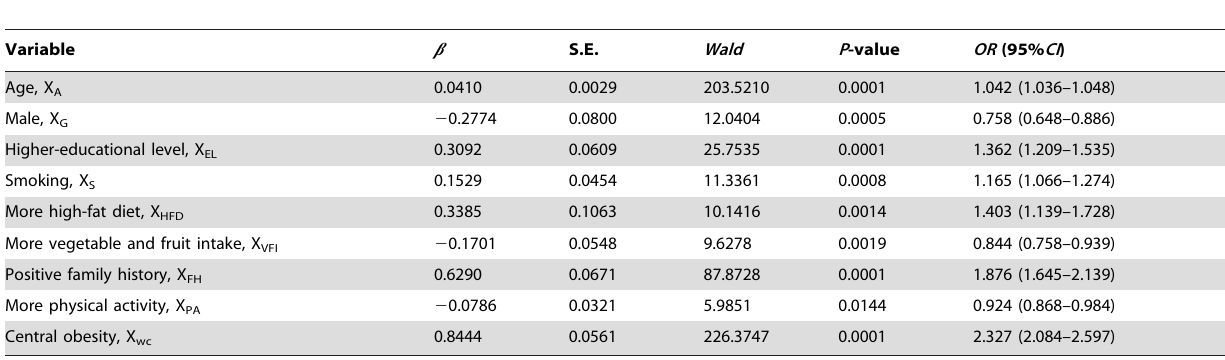
Table 2. Multivariate logistic regression analysis on risk factors of dyslipidemia in the training group.